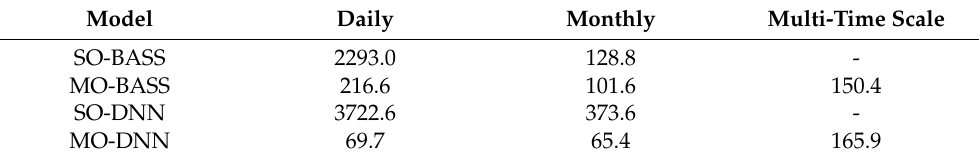
Table 5. The computational time of different time-scale heating energy models (unit: s).